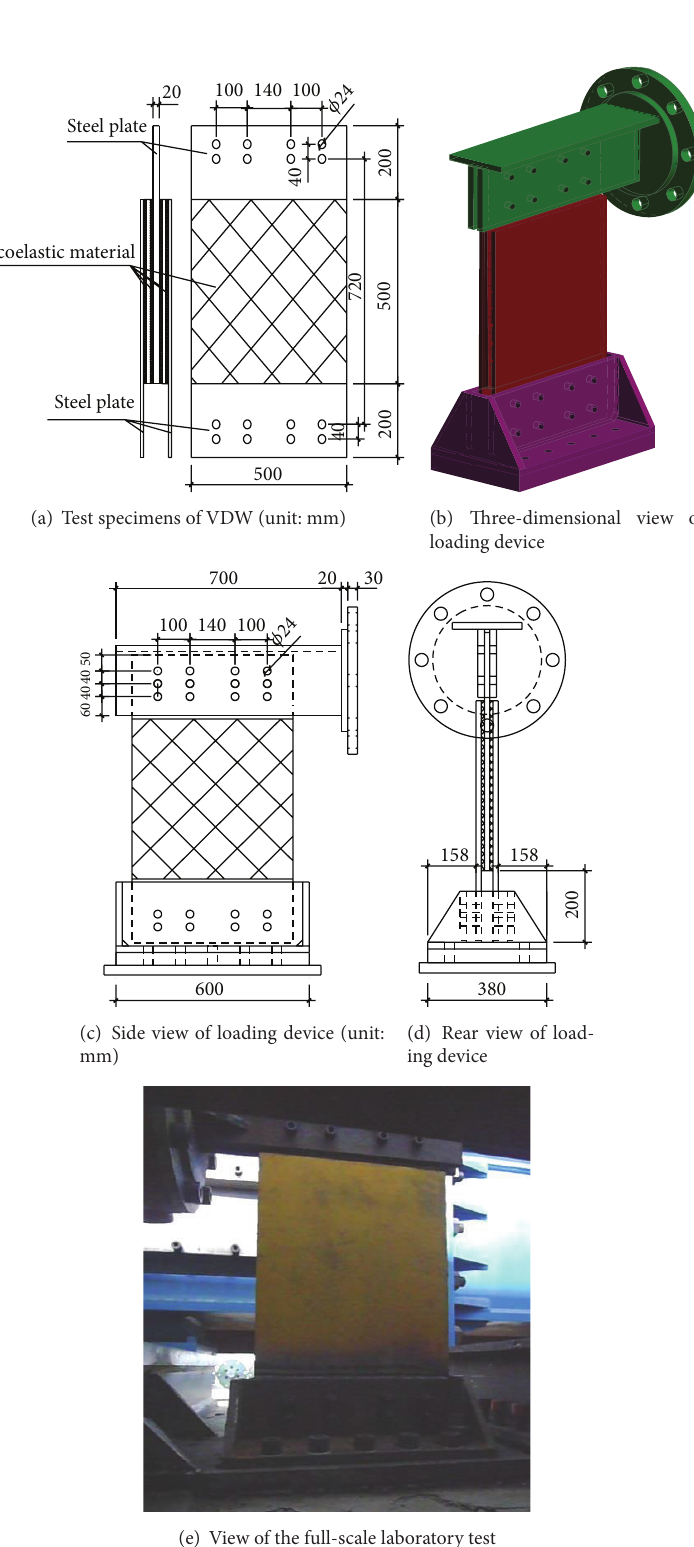
Figure 3: Dimensions of VDW and schematic of the loading